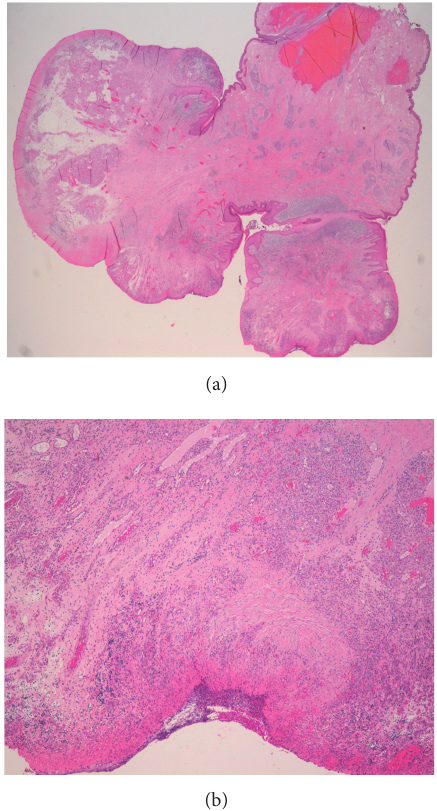
Figure 3: (a) View of the lesion with magnifying glass technique; (b) low power view (H&E 40x) showing the small vessels and ulceration of the